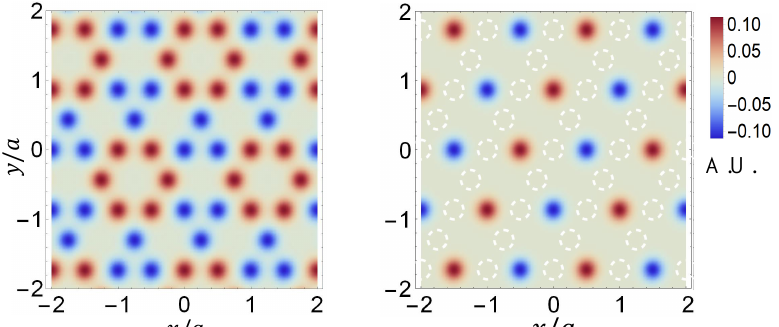
Figure 5: LDOS ˜ ρ α ( r , ω = | ∆ α | ) measured from the average background (relevant to STM images) for cases (i) left panel and (iv) right panel respectively. Dashed circles mark underlying lattice